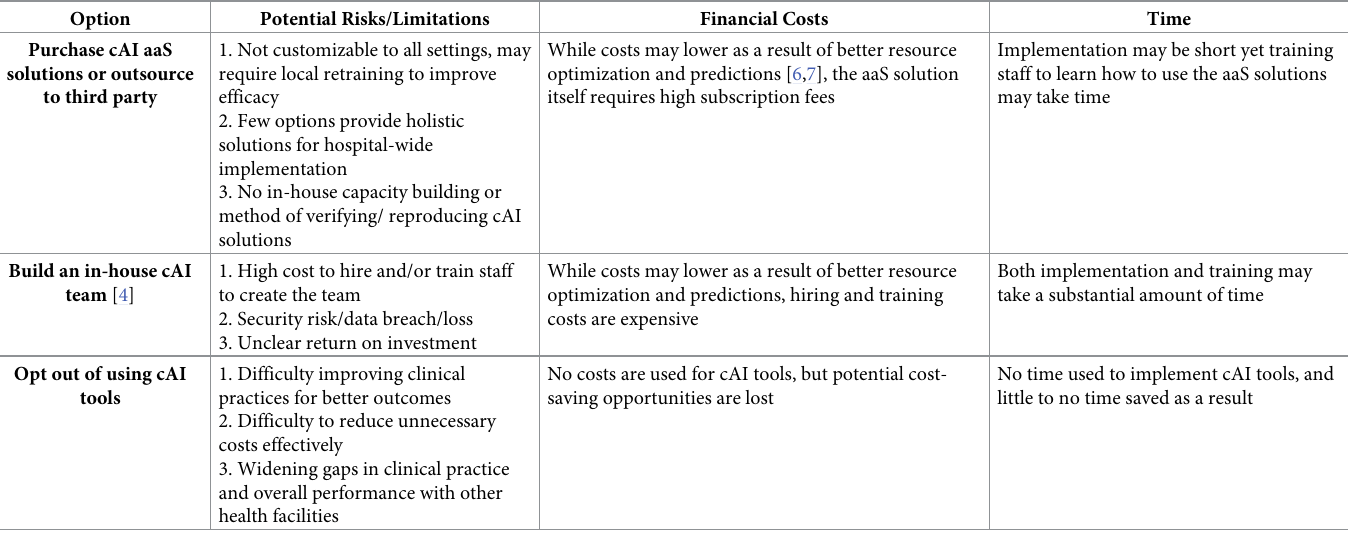
Table 1. High-level overview of the current options for cAI integration at hospital level [2,13].